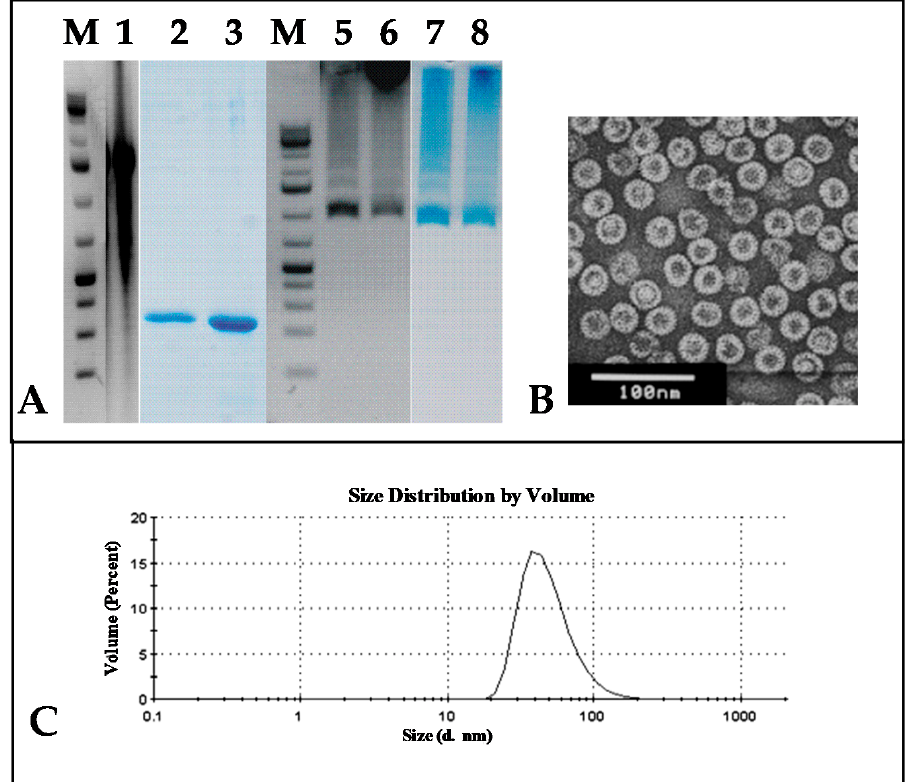
Figure 7. Analysis of HBc/D VLPs packaged with phage PP7 ssRNA. ( A ) M —NAGE in 2% agarose of GeneRuller 1 kb DNA Ladder (SM1331, Thermo Scientific™, Vilnius, Lithuania) and 1 —of phage PP7 RNA; 2 , 3 —SDS-PAGE of packaged VLPs stained with Coomassie Brilliant Blue R-250; 5 – 8 —NAGE of packaged HBc/D VLPs stained with EtBr; 3 , 5 , 7 —supernatant of the packaged VLP preparation; 2 , 6 , 8 —debris of the packaged VLP preparation. ( B ) Electron microscopy of the supernatant of the packaged VLP preparation. ( C ) DLS of the supernatant of the packaged HBc/D VLPs.